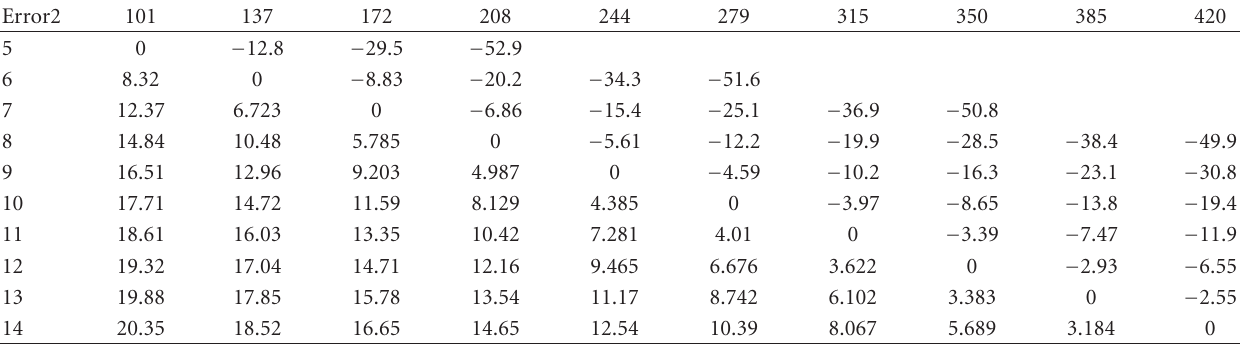
Table 3: MPG 1 versus Hb mix showing estimated error of measured HbA 1c for detection of patient’s MPG in 2-month intervals. Out of range data are ignored.